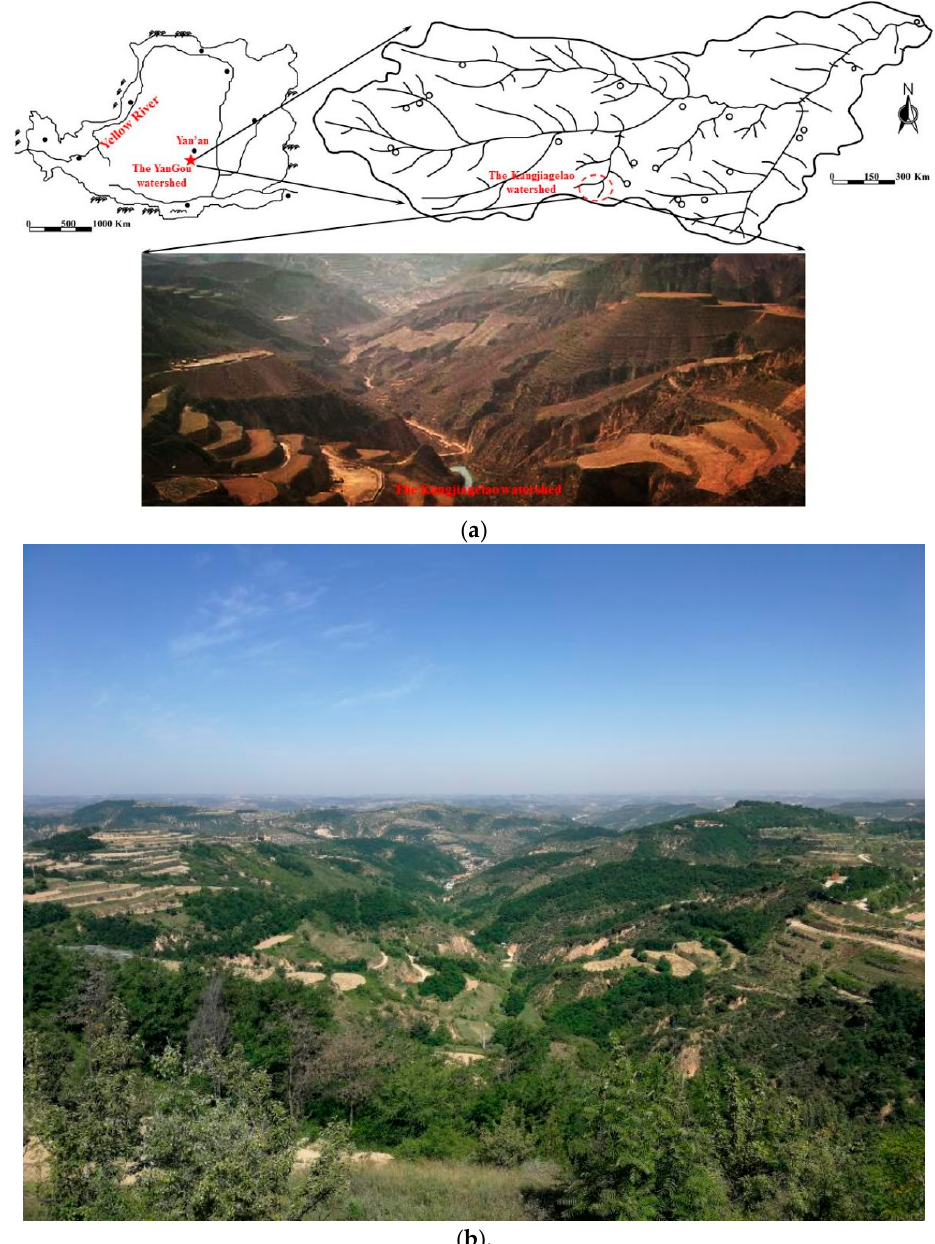
Figure 1. Location and different stages of the Kangjiagelao watershed, ( a ) Location and early status of the Kangjiagelao watershed, ( b ) Current status of the Kangjiagelao watershed.